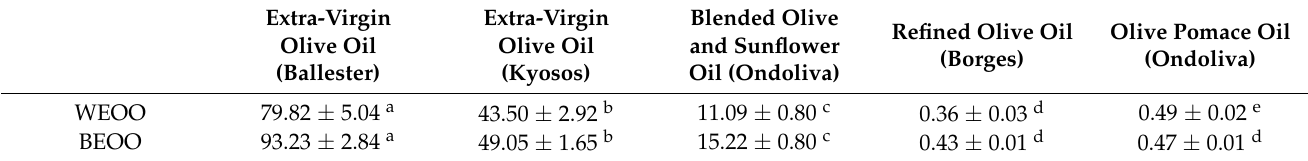
Table 3. Total polyphenol content (GAE mg/L) in WEOO and